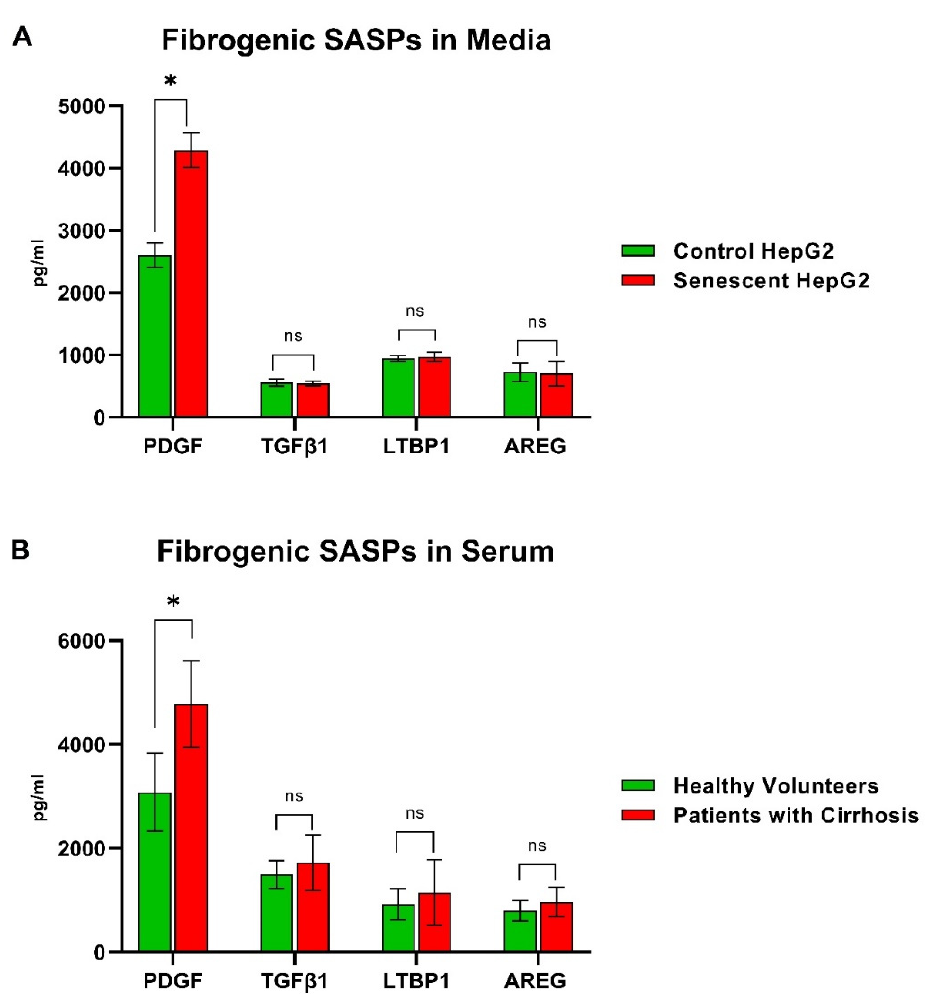
Figure 5. Levels of TGF β 1, LTBP1, AREG, and PDGF, potent hepatic stellate cell activators (fibrogenic senescence-associated secretory factors), in conditioned media from senescent HepG2 cells compared with media from the control HepG2cells ( A ), and in serum samples from patients with cirrhosis compared with serum samples from healthy volunteers ( B ). Experiments were performed in triplicate and the results are expressed as means with SD. The asterisk (*) indicates p < 0.05 and ns indicates no statistical significance.